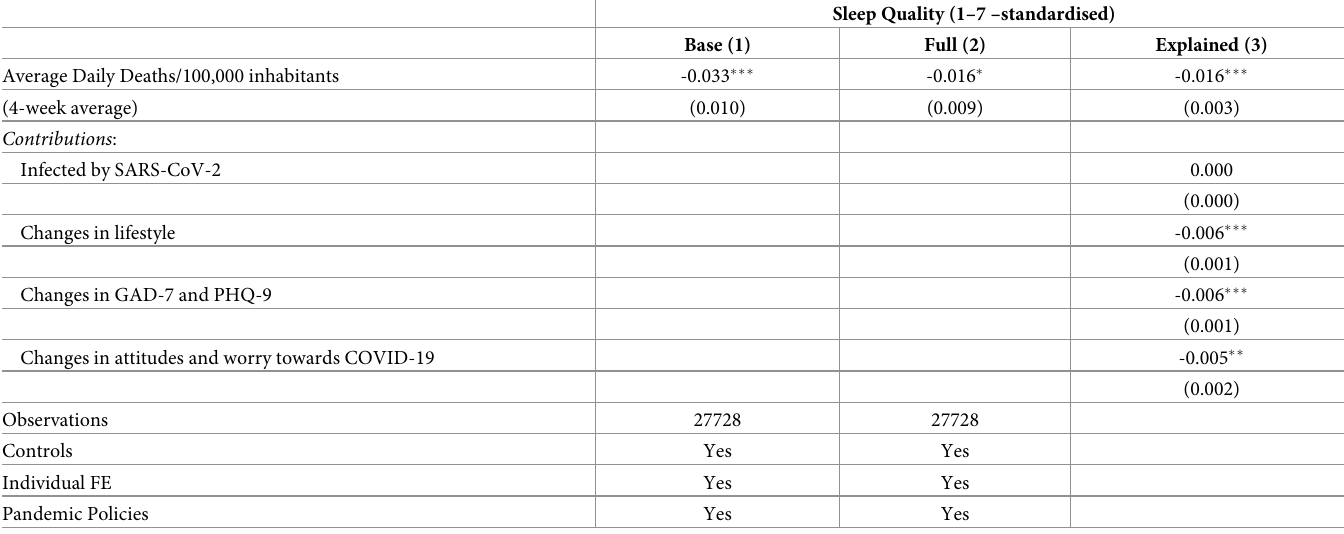
Table 4. Sleep quality and COVID-19 deaths–gelbach